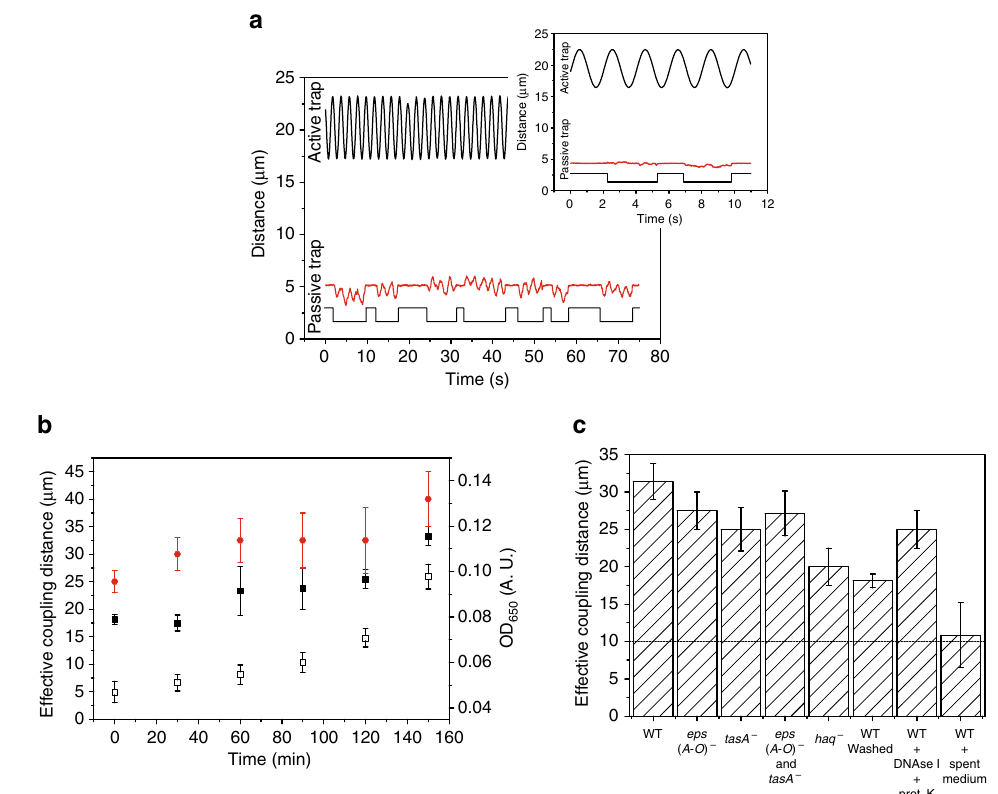
Fig. 2 The effective mechanical coupling of optically trapped bacterial pairs. a A single cell was trapped in the active optical trap and oscillated longitudinally. Amplitude and frequency of oscillations were varied. At a distance d , a second bacterium was trapped and then released to follow the motion of oscillating bacterium. Occasionally, the bacterium escaped from the inactive passive trap and was brought back and released. Trajectories of the active ( black line ) and passive ( red line ) B. subtilis wt stationary cells washed, re-suspended and grown for 2.5 h are depicted ( d = 15 μ m, active trap amplitude 3 μ m, active trap frequency 0.5 Hz, passive trap amplitude 1 μ m). Line below the passive trap trajectory depicts the state of the passive trap (active/inactive). The inset: trace of B. subtilis stationary cells washed, re-suspended and diluted in PBS recorded at the same conditions ( d = 15 μ m, active trap amplitude 3 μ m, active trap frequency 0.5 Hz, passive trap amplitude 1 μ m). b The effective coupling distances between the active and passive B. subtilis bacterium during the incubation of washed and re-suspended stationary phase in SYM medium ( fi lled black squares ), exponentially grown cells that have been diluted and re-grown in SYM growth medium to the exponential phase three times before the optical tweezers measurements ( fi lled red circles ), and optical density of washed and re-suspended B . subtilis wt culture ( open black squares ) Average values and standard errors are given ( n = 8 or more). c The effective coupling distances of B. subtilis wild type after 2.5 h of incubation, eps(A-O) − , tasA − , eps(A-O) − and tasA - , as well as a fl agellate hag - B. subtilis mutants. Coupling distance of washed and re-suspended wild type cells in SYM medium, samples treated with DNAse I and proteinase K enzymes or samples treated with enzymes from the decaying bio fi lm are given. The maximal span of hydrodynamic coupling in simple solutions is indicated with the dashed line. Average values and standard errors are given ( n = 3 or